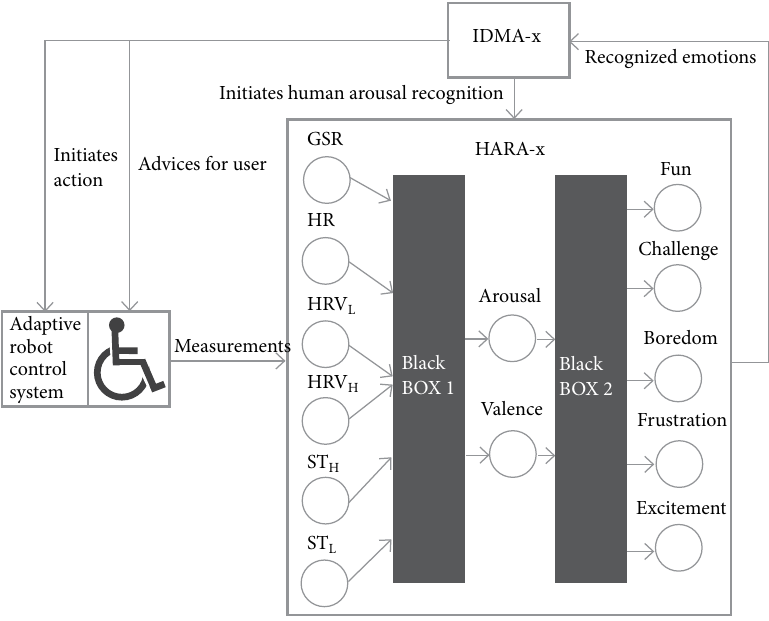
Fig. 9. Fuzzy logical Petri net for the scenario of supporting online relaxation activities for the users with moving